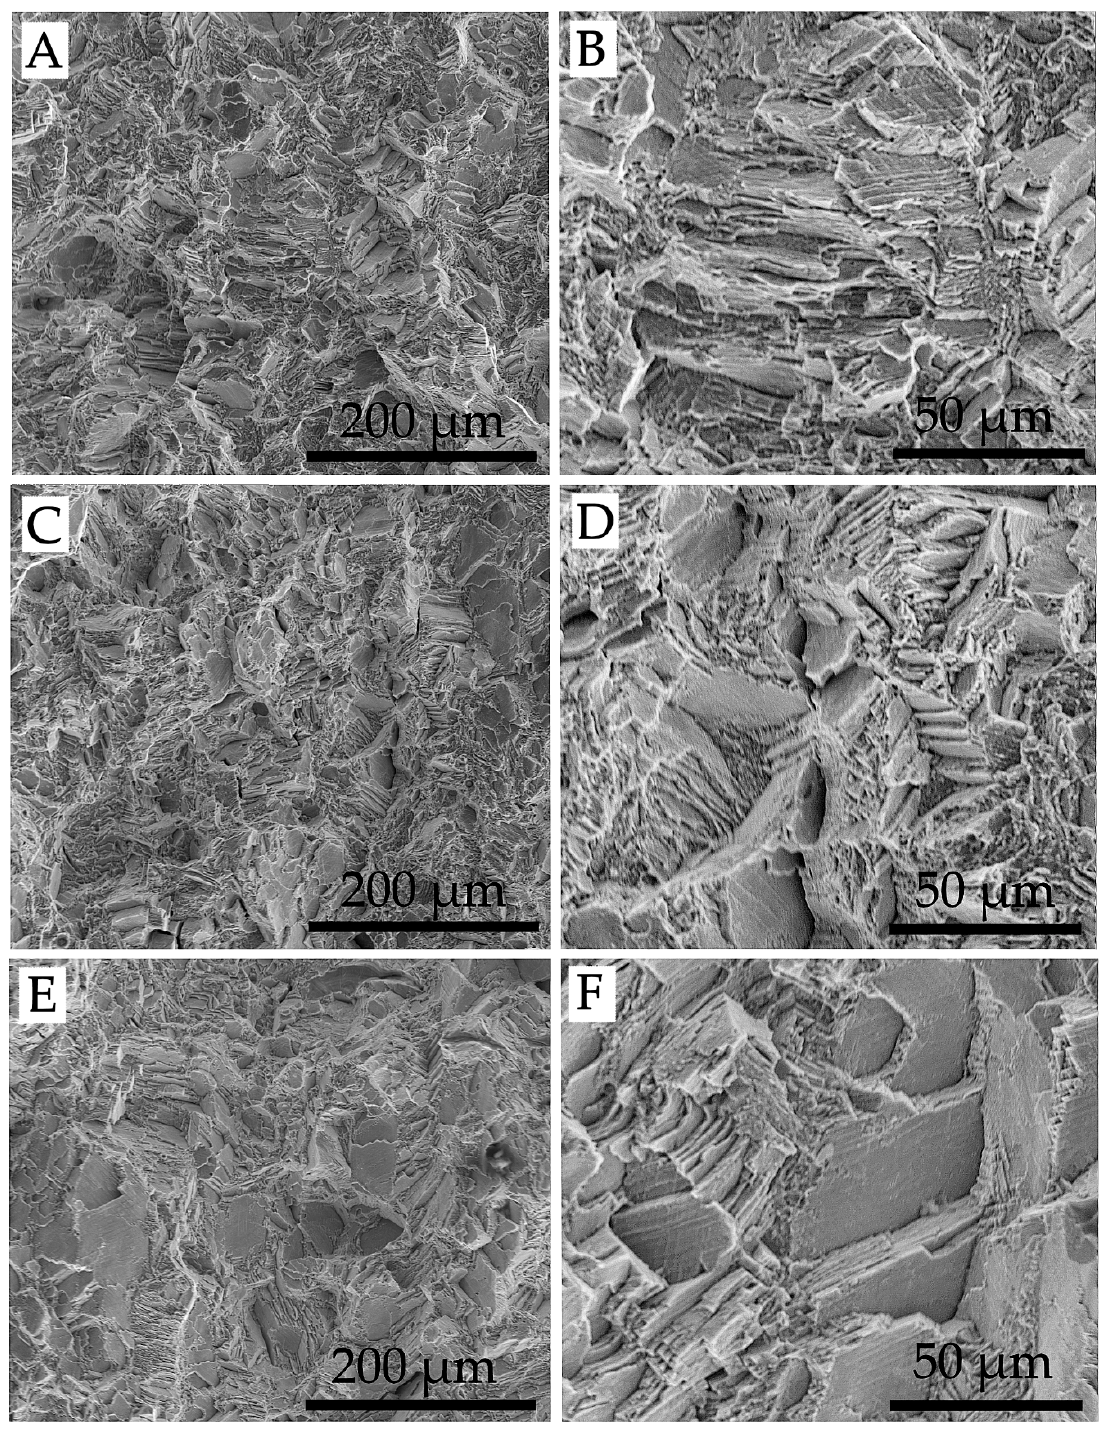
Figure 9. SEM observations of the rupture surface of Co–Cr–Mo specimens: ( A , B ) X; ( C , D ) Y; ( E , F ) XY.